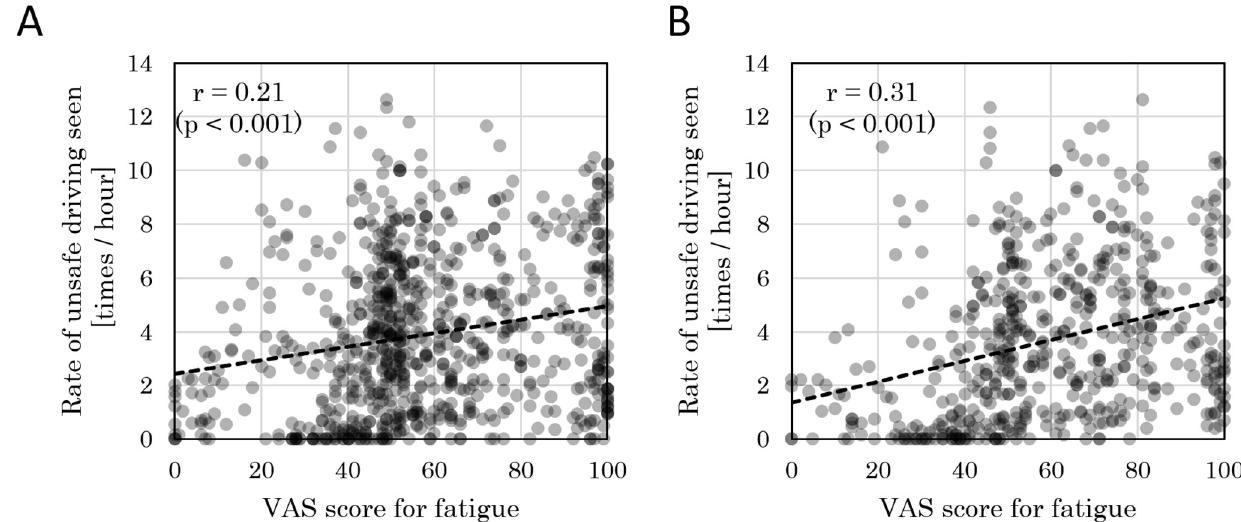
Fig 1. Relationship between the daily collision risk index and VAS for fatigue. (A) Correlation results for visual analogue scale (VAS) score of fatigue in the pre-shift condition, (B) VAS score of fatigue in the post-shift condition, and collision risk judgment frequency (normalized) R 1hr . Pearson’s correlation coefficient and the p -value are as